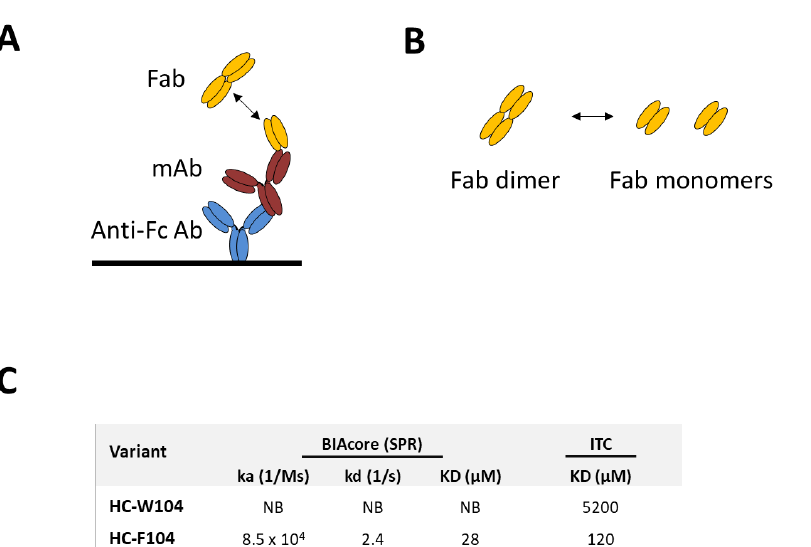
Figure 4. Schematics diagramming ( A ) BIAcore Surface Plasmon Resonance (SPR) format where the mAb serves as the ligand and the Fab of interest, shown here as an equilibrium of monomer and dimer forms, as the analyte. ( B ) Isothermal Calorimetry (ITC) format (in solution) where the Fab of interest is shown as an equilibrium of Fab dimer and monomer. In the experiment, the Fab is dimerized and is fast diluted to initially favor the monomer. (C) Measured affinities or KDs (nM) are tabulated for both approaches, including kd and ka for SPR.